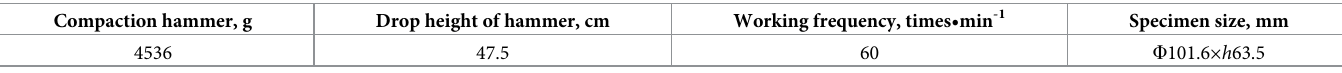
Table 8. Working parameters of the Marshall compactor.